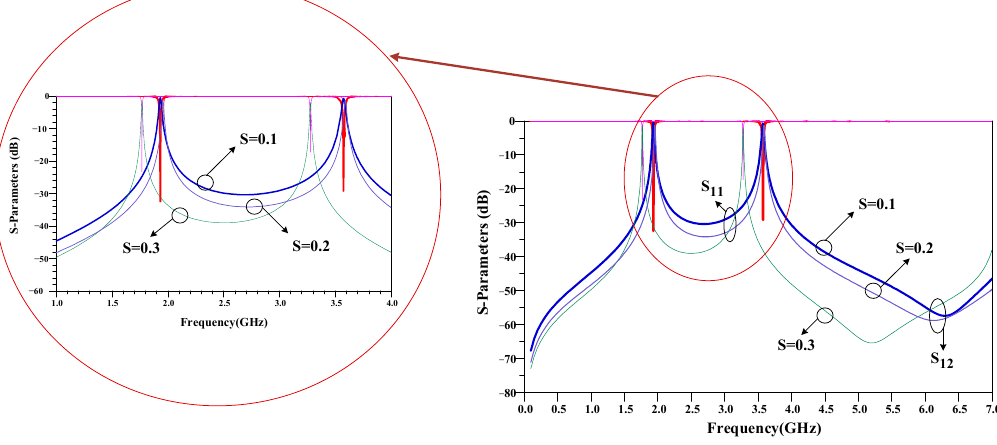
Figure 9. Effects of gap space (S) in the second proposed BPF at 1.7/3.3 GHz. rectangular loop and triangular loop resonators are designed. In step2, the designed